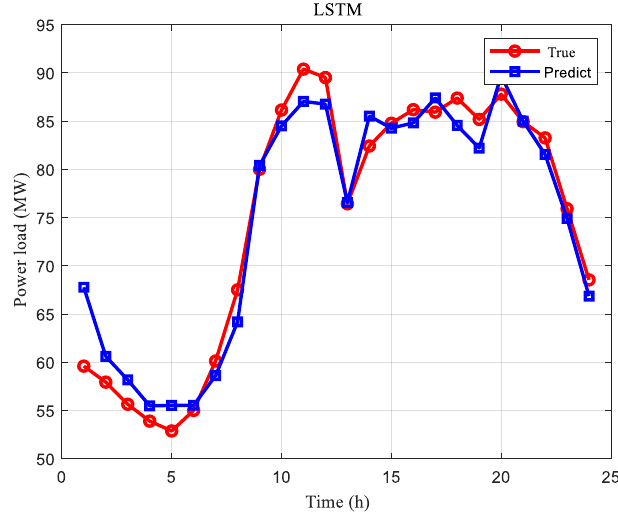
Figure 8. LSTM model forecasting curve vs. true value of load.